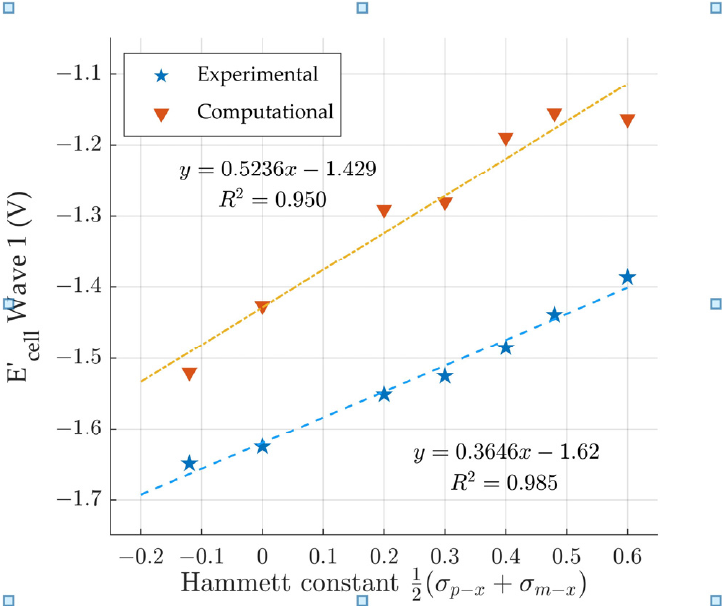
(cid:2869) (cid:0) (cid:1) (cid:3435)𝜎 + 𝜎 (cid:3439) [41] vs computationally predicted σ p − x + σ m − x [41] vs computationally predicted (cid:3043)(cid:2879)(cid:3051) (cid:3040)(cid:2879)(cid:3051) 2 (cid:2870)